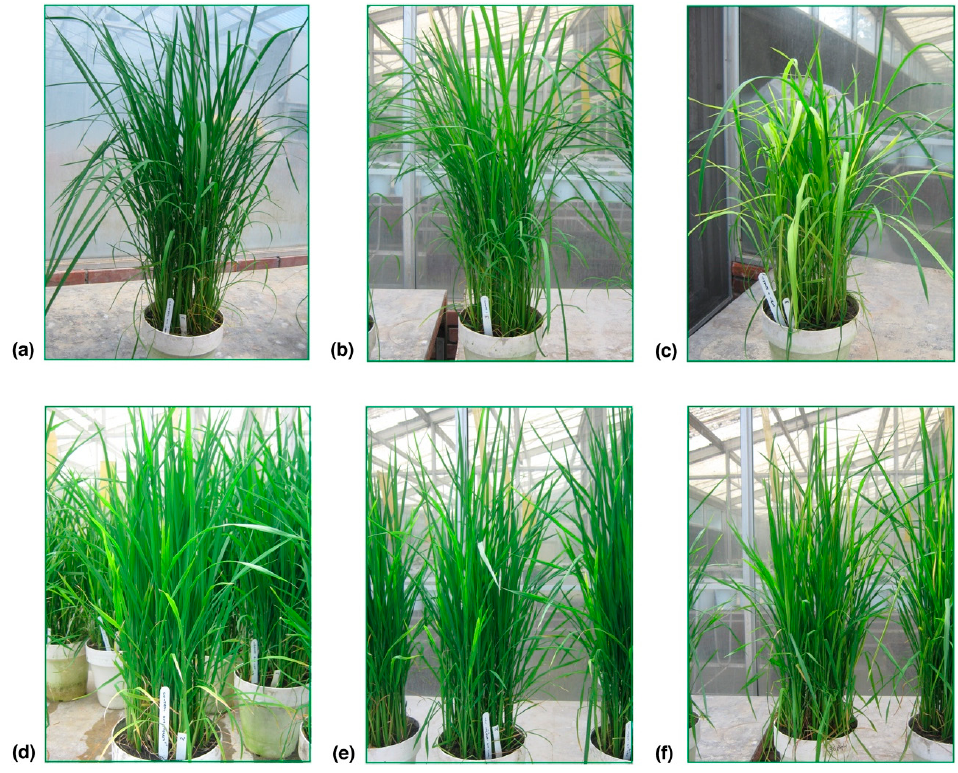
Figure 1. The effect of the insect and RHBV exposure of the two varieties. Colombia I variety: control ( a ), non-infected insect ( b ), and insect infected with RHBV ( c ). Fedearroz 2000 variety: control ( d ), non-infected insect ( e ), and insect infected with RHBV ( f ).